Question: What type of chart is this?
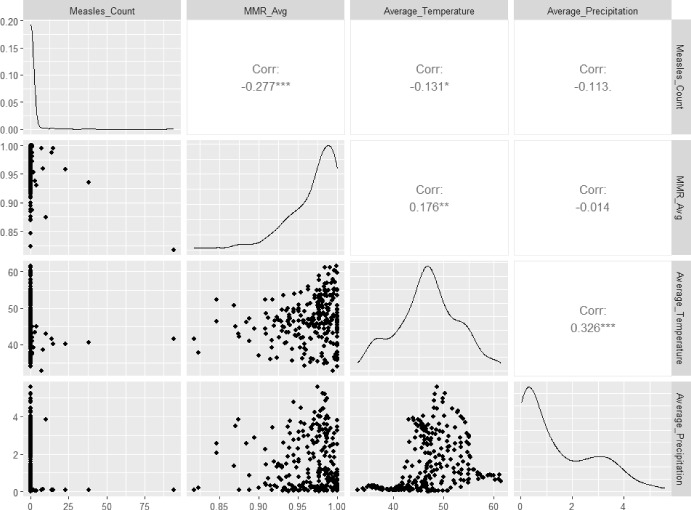
Answer: scatter